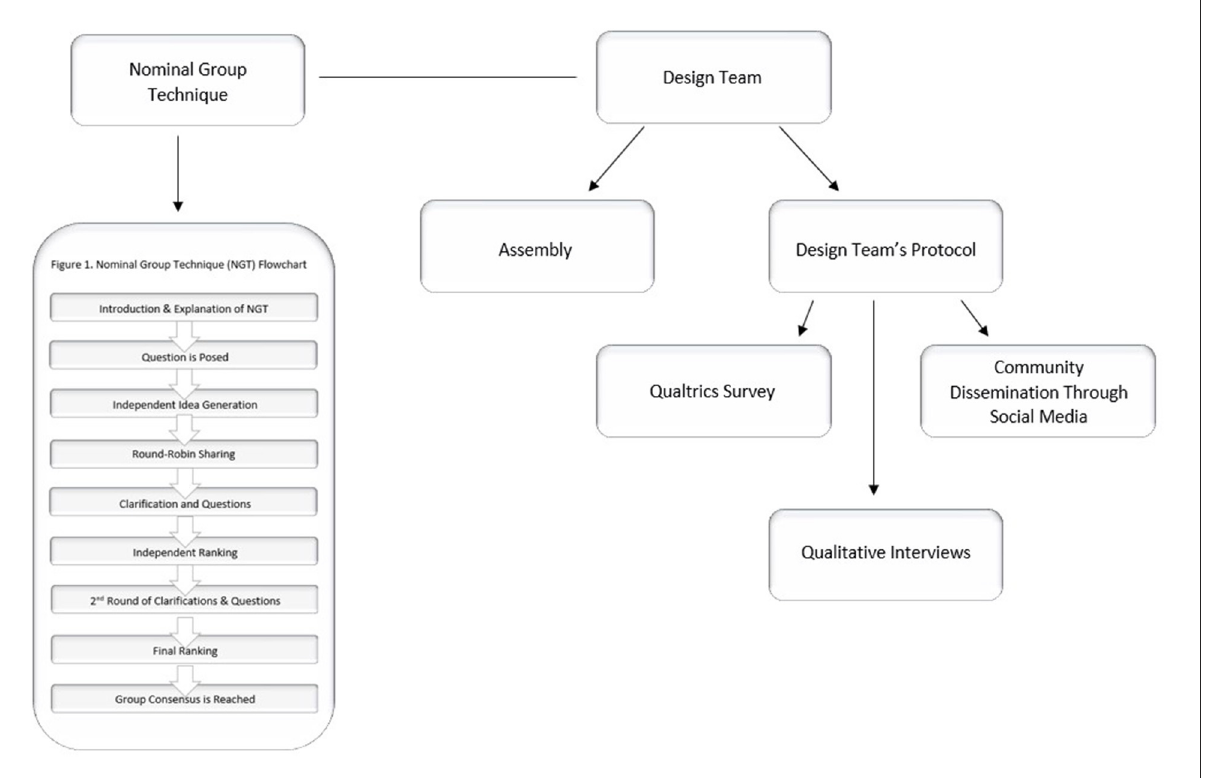
FIGURE2 Project overview highlighting multipronged